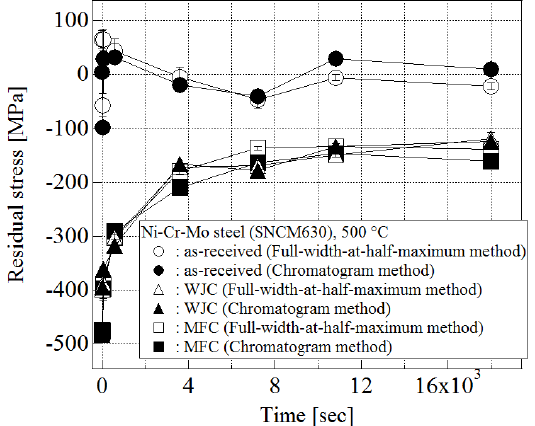
Figure 3. Time dependence of residual stress for Cr–Mo steel (SCM435).